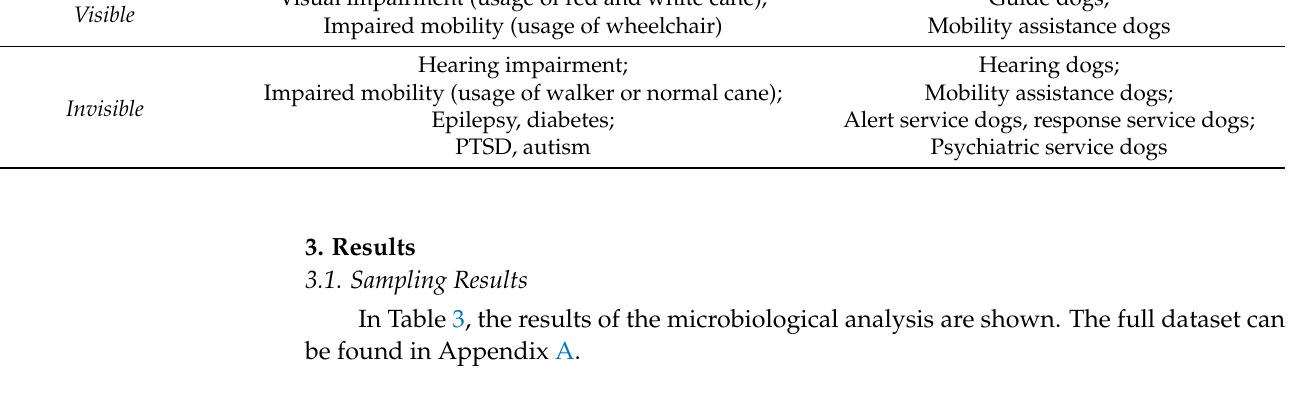
Table 2. Examples of visible and invisible disabilities, accompanied by frequently used types of assistance dogs (ADs) [8]. Type of